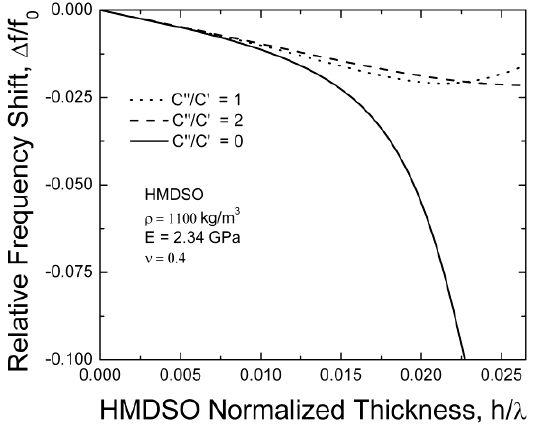
Figure 5. Theoretical mass sensitivity as function of layer viscosity.